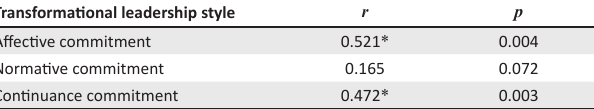
TABLE 3: The relationship between perceived transformational leadership style and employee organisational commitment constructs.